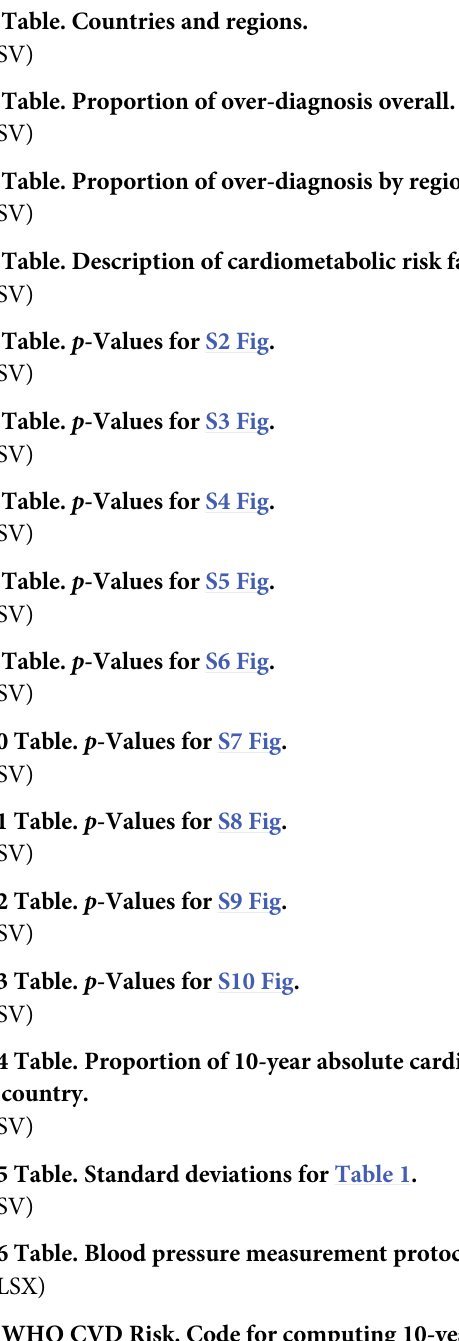
S1 Table. Countries and regions. S2 Table. Proportion of over-diagnosis overall. S3 Table. Proportion of over-diagnosis by region. S4 Table. Description of cardiometabolic risk factors by country. S5 Table. p -Values for S2 Fig. S6 Table. p -Values for S3 Fig. S7 Table. p -Values for S4 Fig. S8 Table. p -Values for S5 Fig. S9 Table. p -Values for S6 Fig. S10 Table. p -Values for S7 Fig. S11 Table. p -Values for S8 Fig. S12 Table. p -Values for S9 Fig. S13 Table. p -Values for S10 Fig. S14 Table. Proportion of 10-year absolute cardiovascular risk comparing diagnosis status by country. S15 Table. Standard deviations for Table 1. S16 Table. Blood pressure measurement protocol by